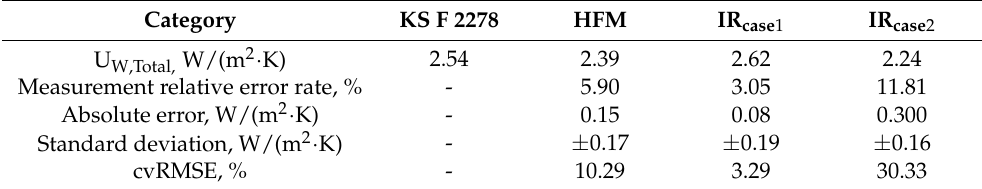
Table 9. Window U-value error rate analysis by measurement